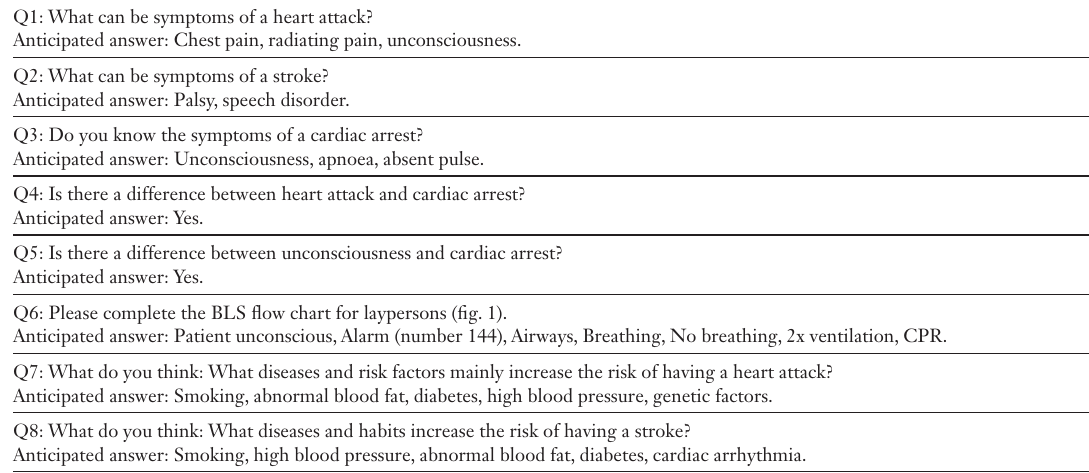
Table 3 Questions (Q) and corresponding correct answers.